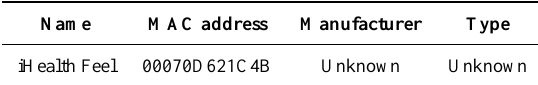
Table 2. Connected IoMT device’s specifications